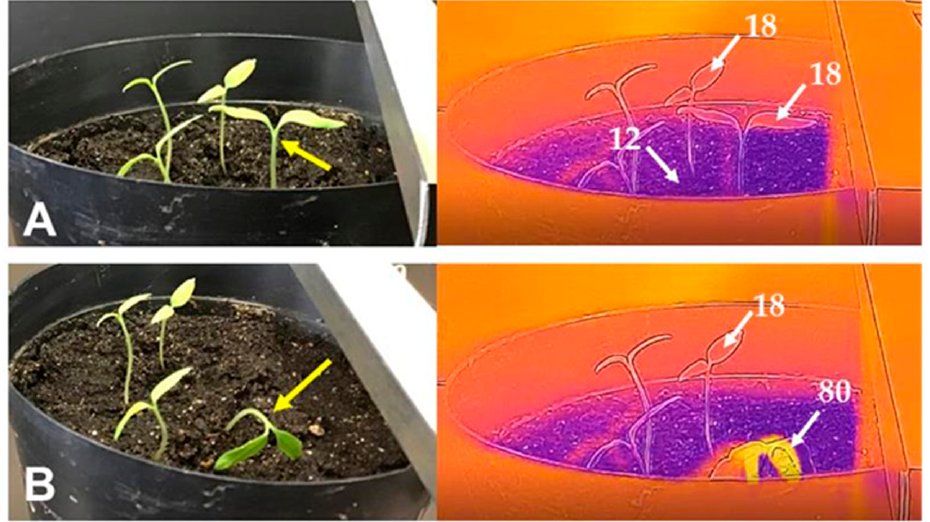
Figure 5. Thermographic detection of arc-discharge-exposed (yellow arrow) and non-exposed shoots of test plants (tomato) sown in pot soil before ( A ) and after arc-discharge exposure at − 12 kV charge ( B ). Figures in the thermograms represent temperature ( ° C) measured with a spot temperature meter of a camera. White arrow represents the site of temperature measurement. Note that the arc-discharge-exposed shoot exhibited the highest temperature color (yellow).